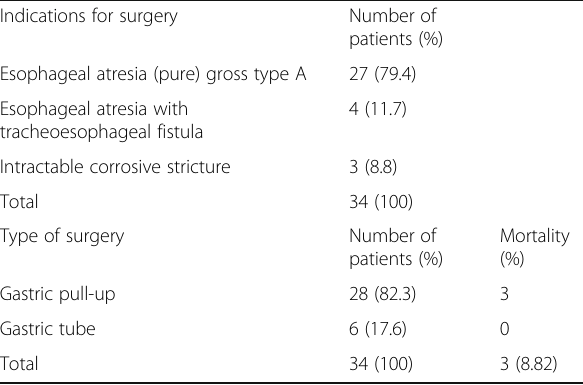
Table 2 Indication for surgery, types of surgical procedures,